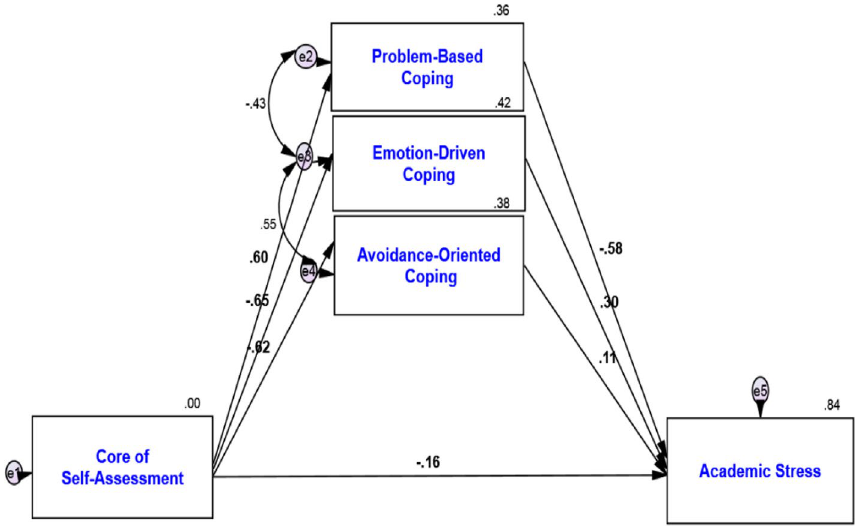
Fig. 2 Model fit in standard estimation mode